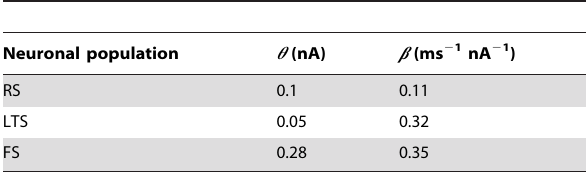
Table 1. Reference parameters for the neuronal populations, based on [7].